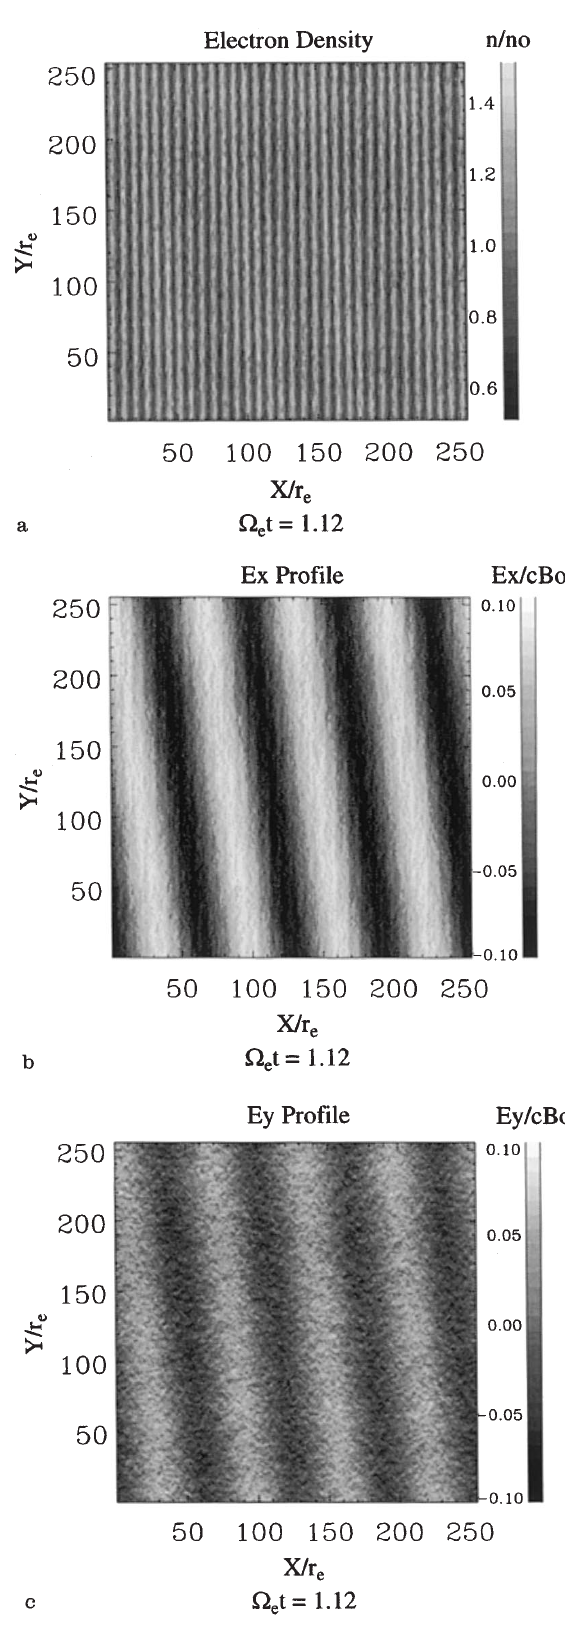
Fig. 4a–c. Contour plots of a n e , b E x , c E y , at t (cid:136) 1 : 12 = (cid:88) e . A strong coupling with the density irregularity at the short wavelength is found in E x